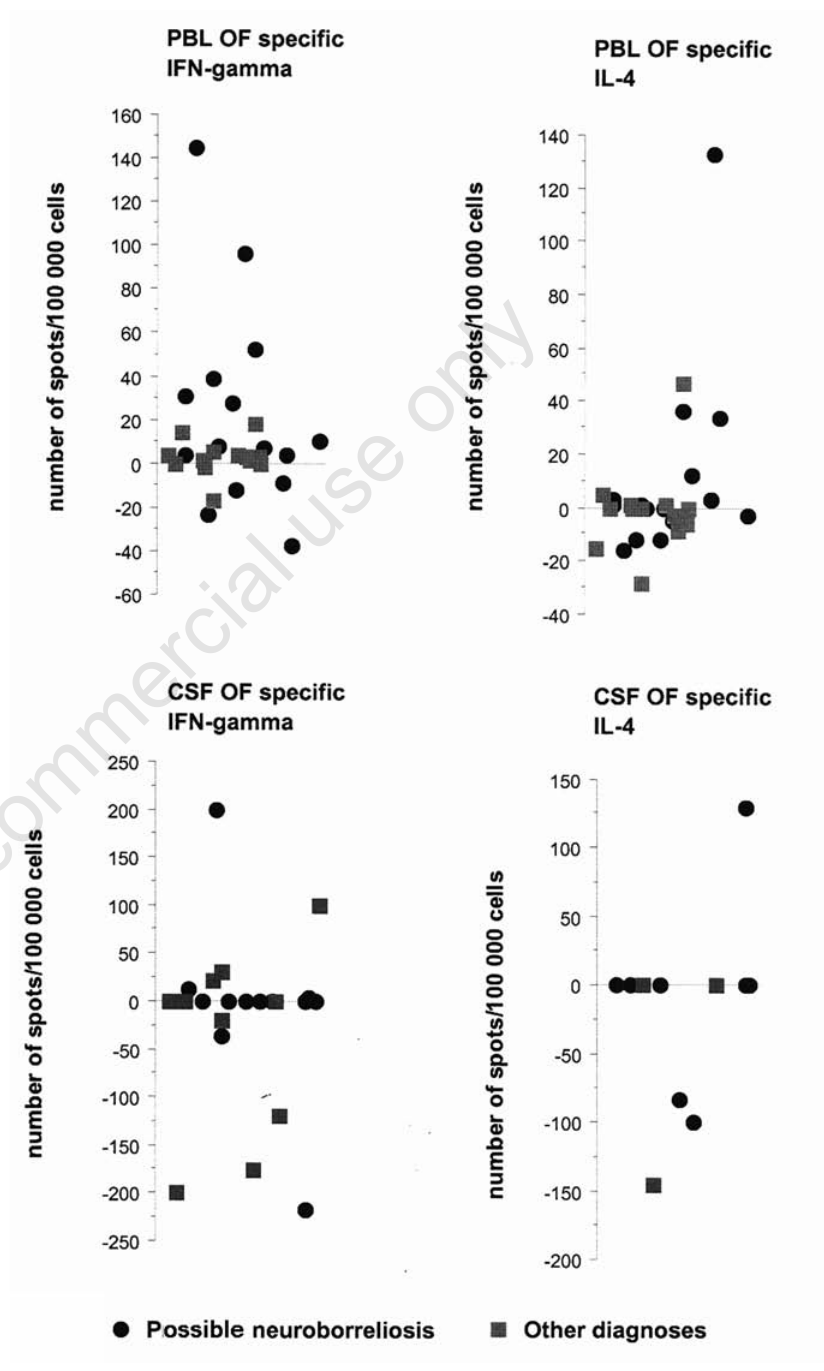
Figure 1. Number of Borrelia specific IFN- γ and IL-4 secreting cells per 100.000 lympho- cytes in cerebrospinal fluid and peripheral blood in patients with probable neuroborre- liosis and patients with other diagnoses as measured by ELISPOT. The Borrelia specific secretion was obtained by subtracting the number of spots in unstimulated wells from the number in Borrelia OF-stimulated